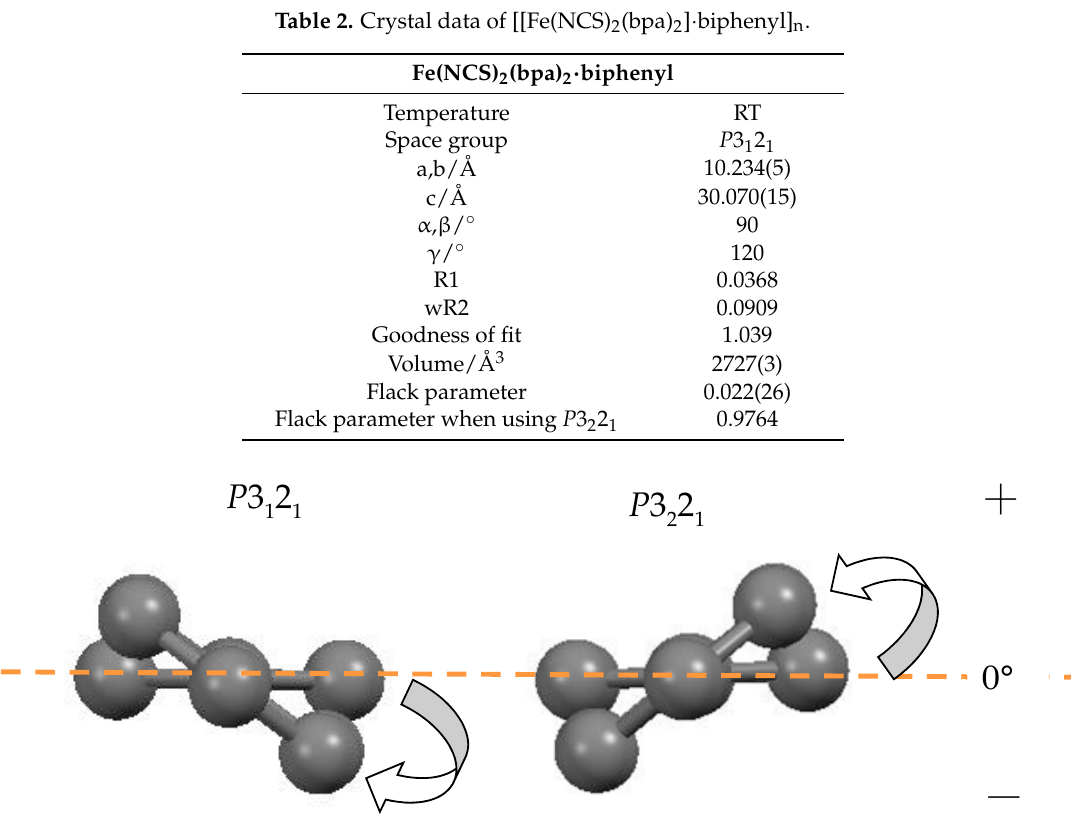
Figure 3. Structure of biphenyl. The dashed line shows a phenyl plane in the rear.